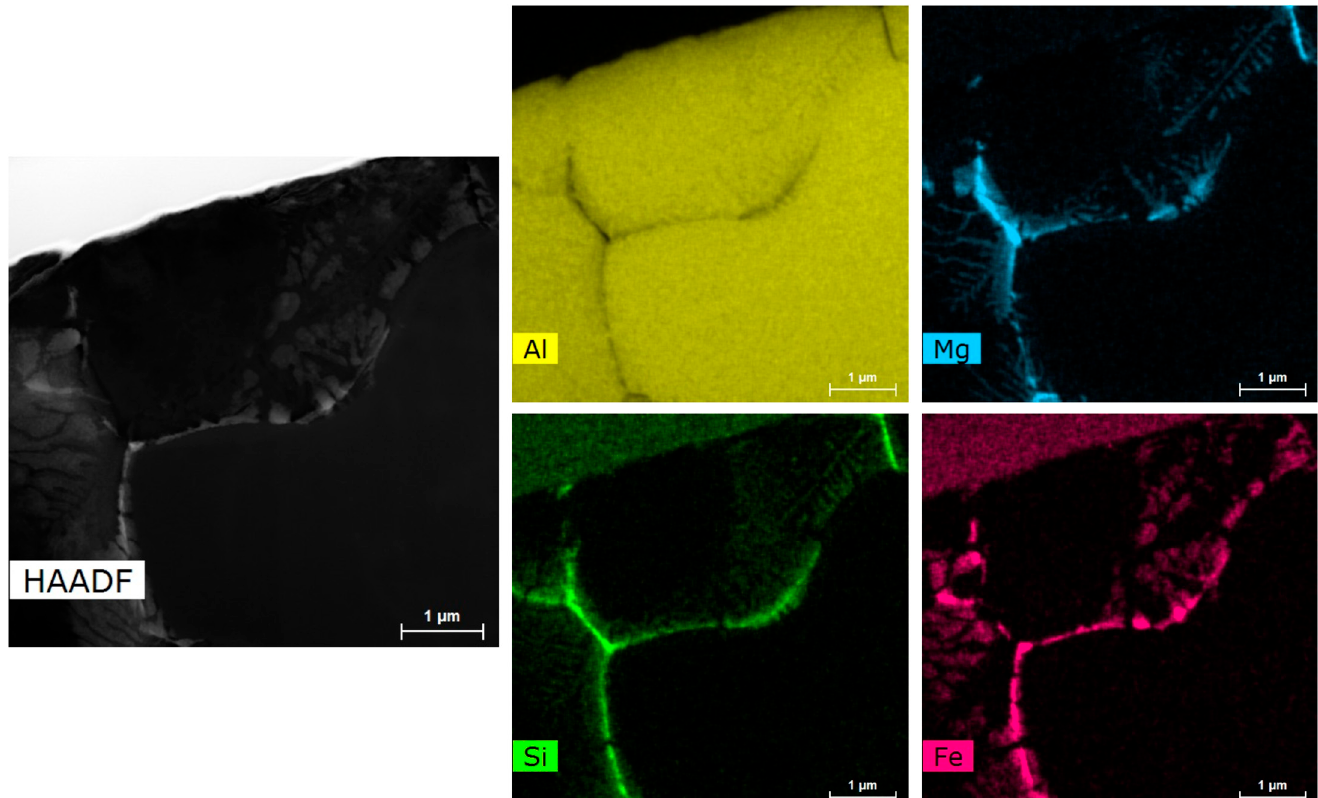
Figure 8. The subfigure labeled “HAADF” presents a HAADF-STEM micrograph affiliated with two larger polycrystalline boundary regions for an as-atomized Al 6061 powder particle. The colored micrographs labeled with Al, Mg, Si, and Fe present the respective EDS-derived elemental maps for the area presented in the HAADF micrograph. Note that the scale bars are all 1 μ m.